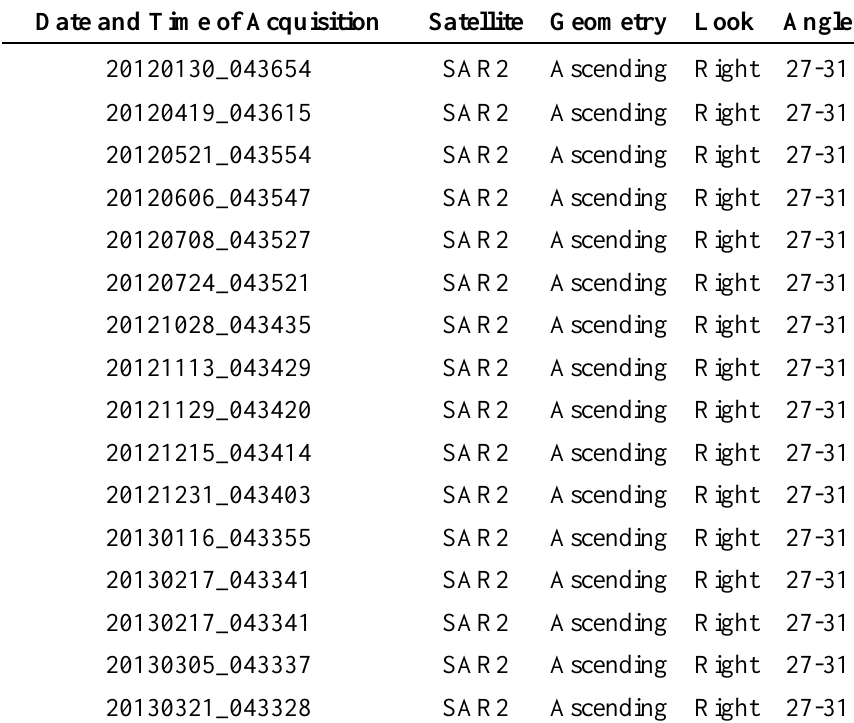
Table 1. List of COSMO-SkyMed (CSK images) acquired for the landslide analysis. In bold post-event